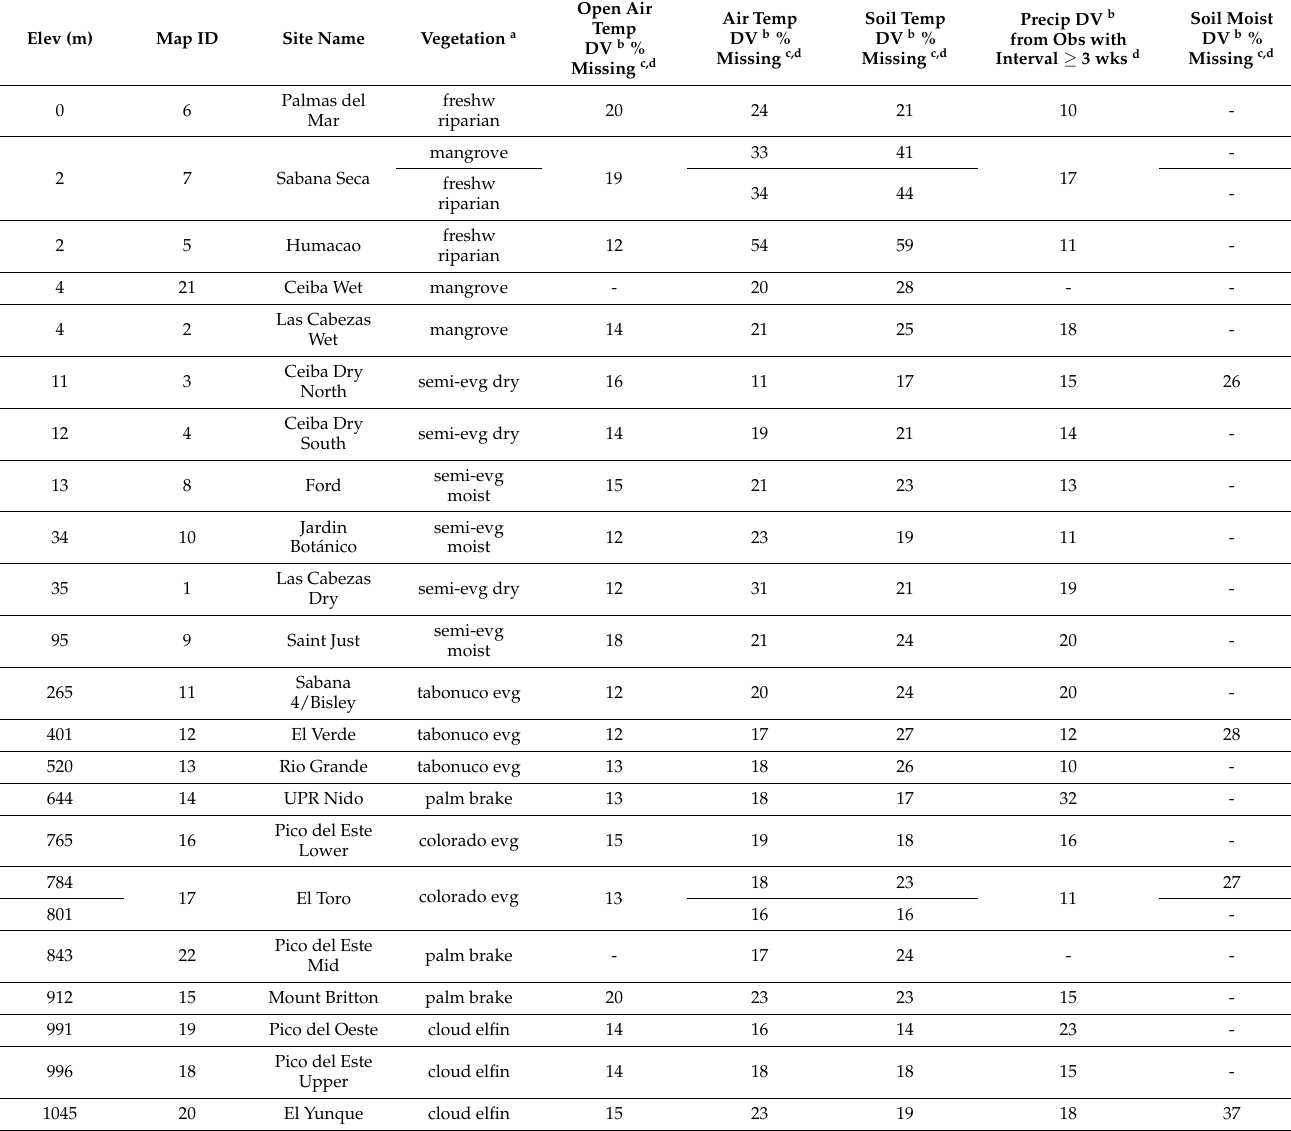
Table 1. Summary of Type and Completeness of Daily Value Data Collected at each